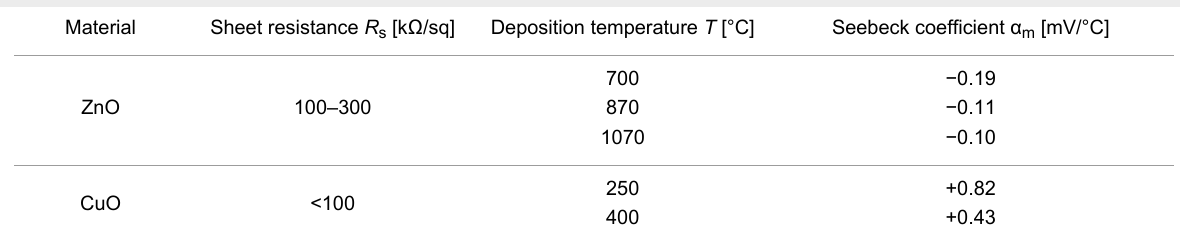
Table 1: Measured Seebeck coefficients of the fabricated ZnO and CuO nanowires